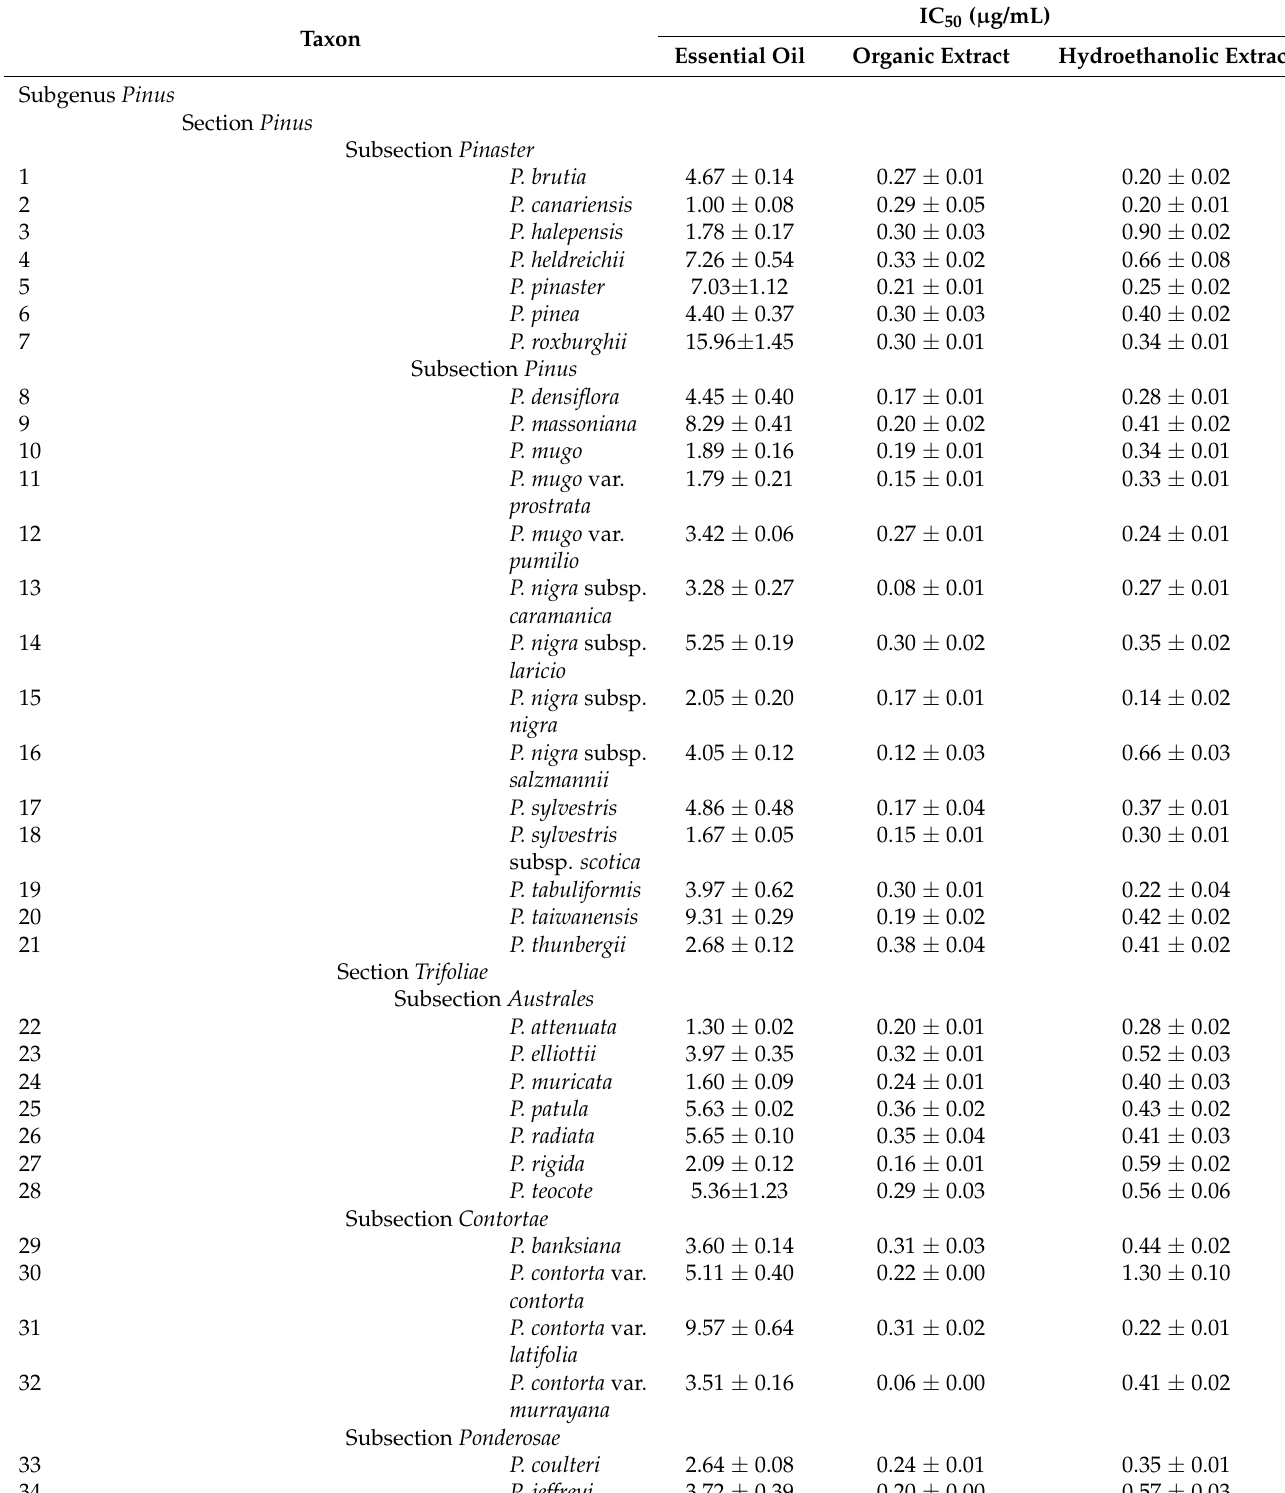
Table 1. Antioxidant activity (expressed as IC 50 in µ g/mL) of the essential oils, the organic (CH 2 Cl 2 /EtOH 2:1) and the hydroethanolic (EtOH/H 2 O 1:2) extracts of the fresh needles of 54 Pinus taxa. Taxon